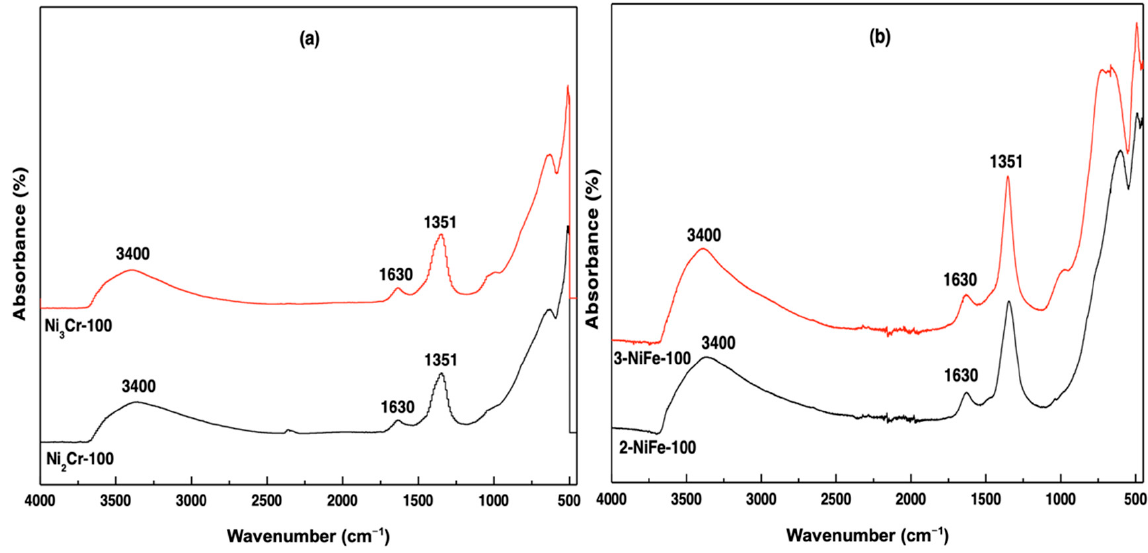
Figure 3. IR-ATR spectra of Ni R Cr ( a ) and Ni R Fe ( b ) LDH precursors. 2.2. Thermal Decomposition (HT-XRD and TG-DTA) of LDH Precursors The recorded TG-DTA thermograms when Ni R Fe and Ni R Cr LDH were subjected to thermal decomposition are shown in Figure